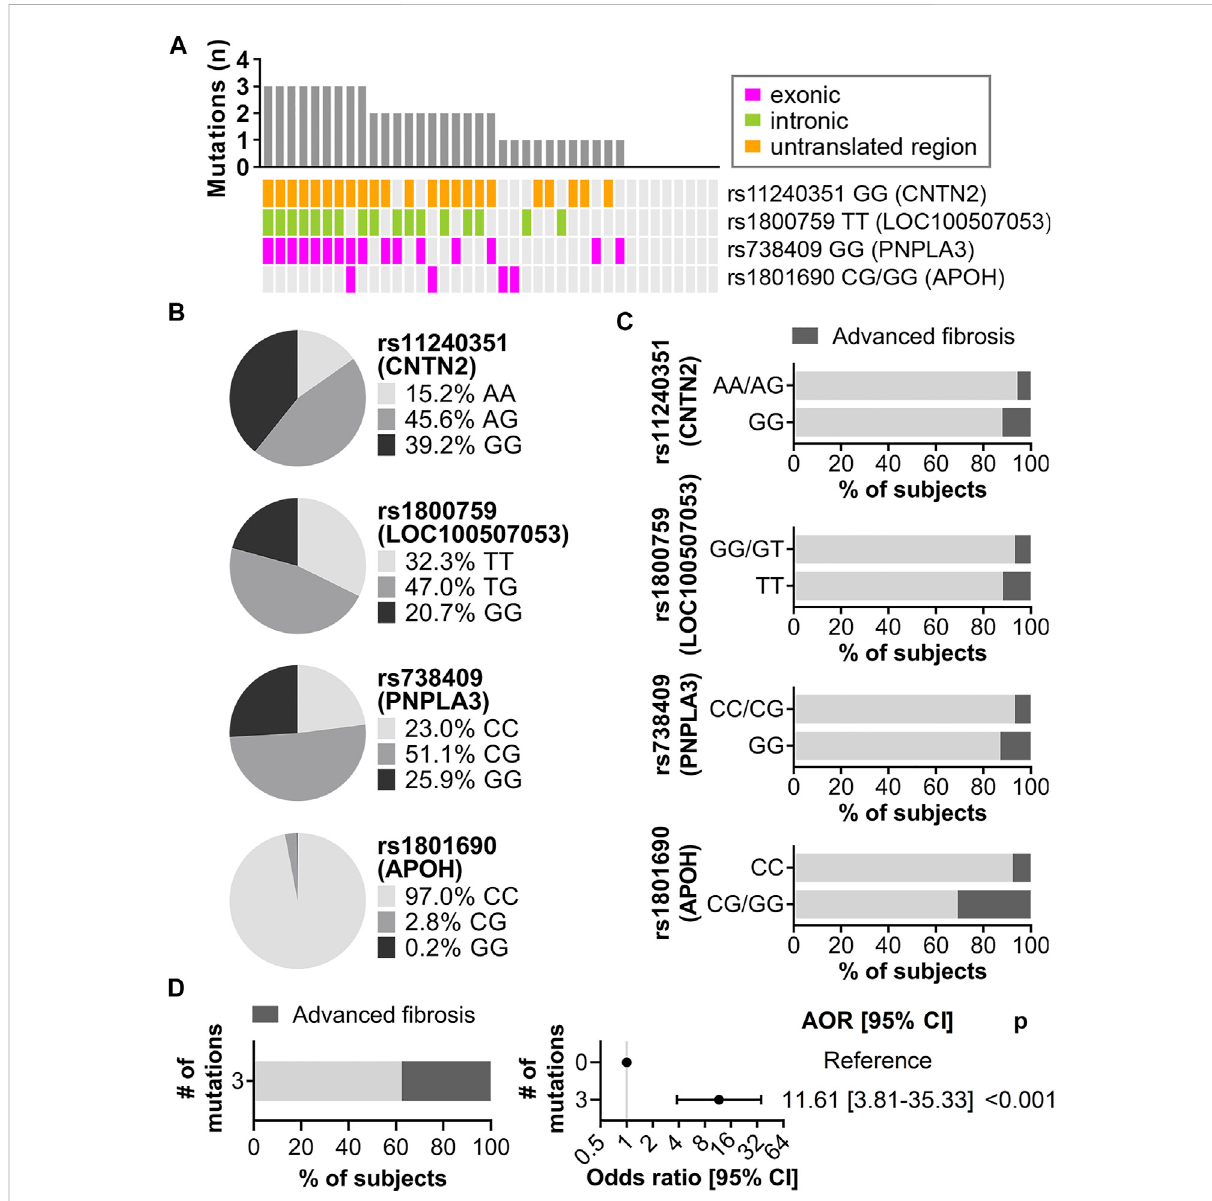
FIGURE 5 Main contributors to risk of advanced liver fi brosis identi fi ed by ridge regression and random forest. (A) Mutation landscape of the top four variants in CCHC subjects with advanced fi brosis. The bar chart represents the number of variants in each subject. Each column represents one subject and each row represents one variant. (B) Genotype frequency of the four variants in the CCHC cohort. (C) Percentage of subjects with advanced fi brosis by genotype. (D) Left, percentage of subjects with advanced fi brosis in subjects with three of the four variants. Right, forest plot showing AOR [95% CI] for advanced liver fi brosis in subjects with three of the four